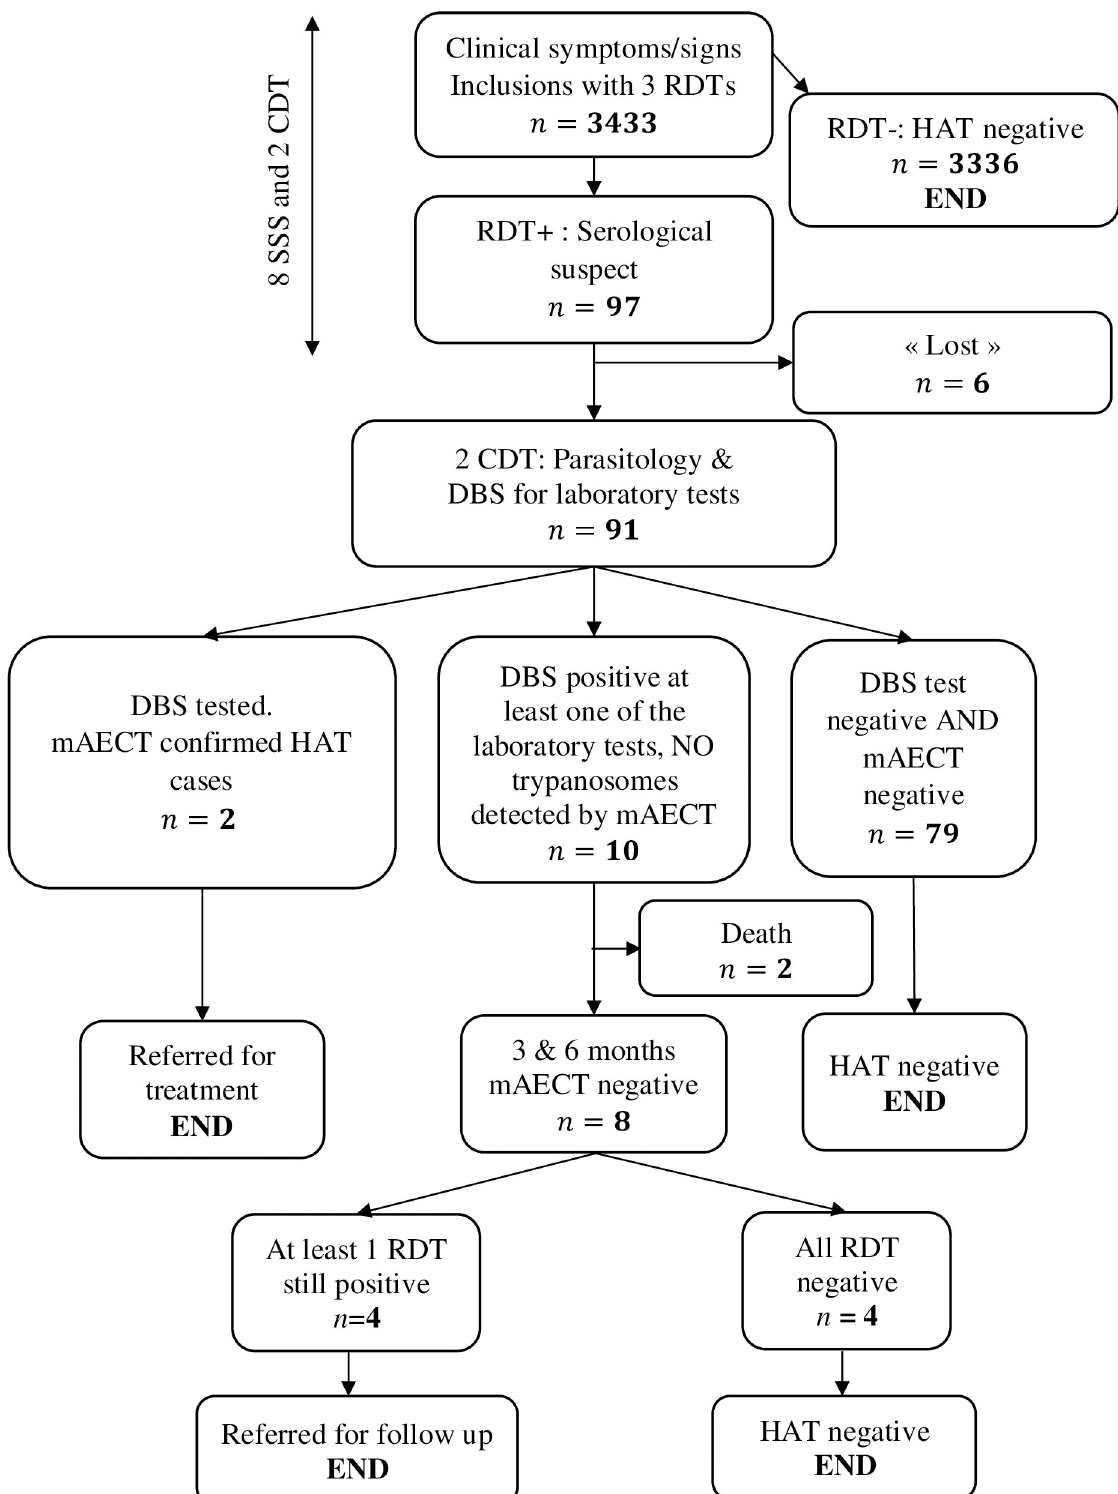
Fig 1. Flow chart of study participants with tests results. RDT rapid diagnostic test, HAT human African trypanosomiasis, SSS serological screening site, CDT centre for diagnosis and treatment, DBS dried blood spot, mAECT mini anion exchange centrifugation technique.